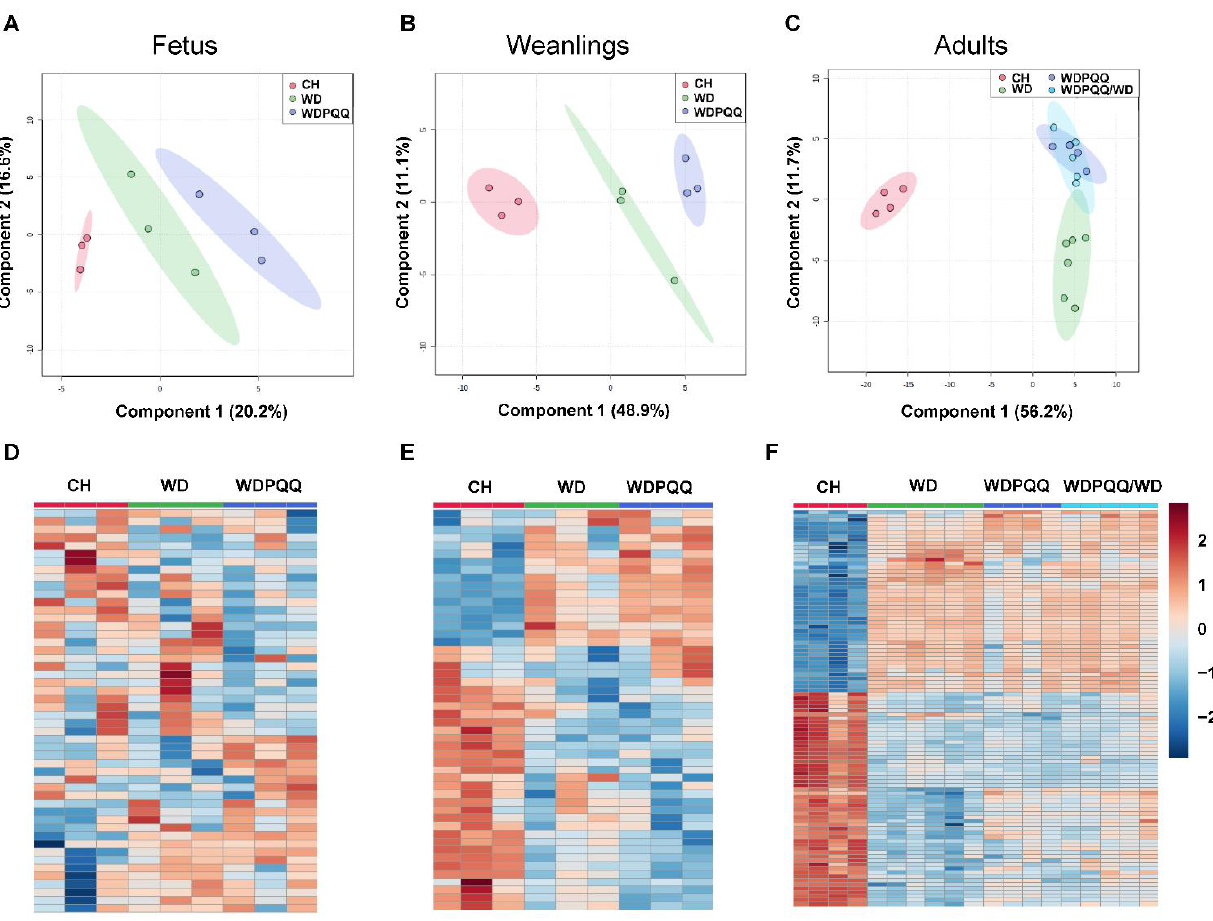
Figure 3. Diet and PQQ alter hepatic lipid profiles. MetaboAnalyst 5.0 was used to analyze mass- spectrometry-based lipidomics datasets from fetuses, weanlings, and adults. Data were normalized using log10 transformation and autoscaling. PLS-DA score plots for fetuses ( A ), weanlings ( B ), and adults ( C ). Heatmaps with significantly altered lipids for fetuses ( D ), weanlings ( E ), and adults ( F ).